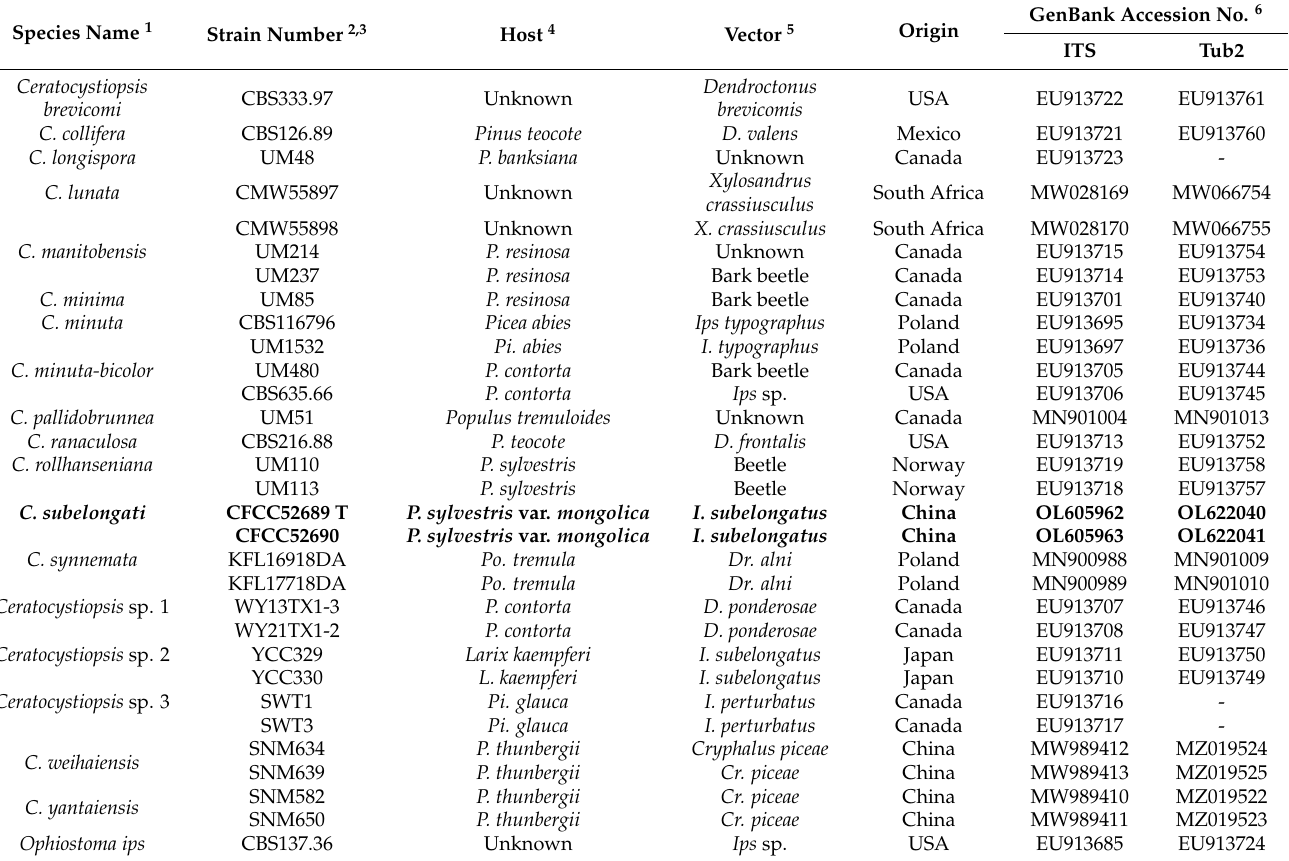
Table 1. Information of strains used for phylogenetic analysis in this